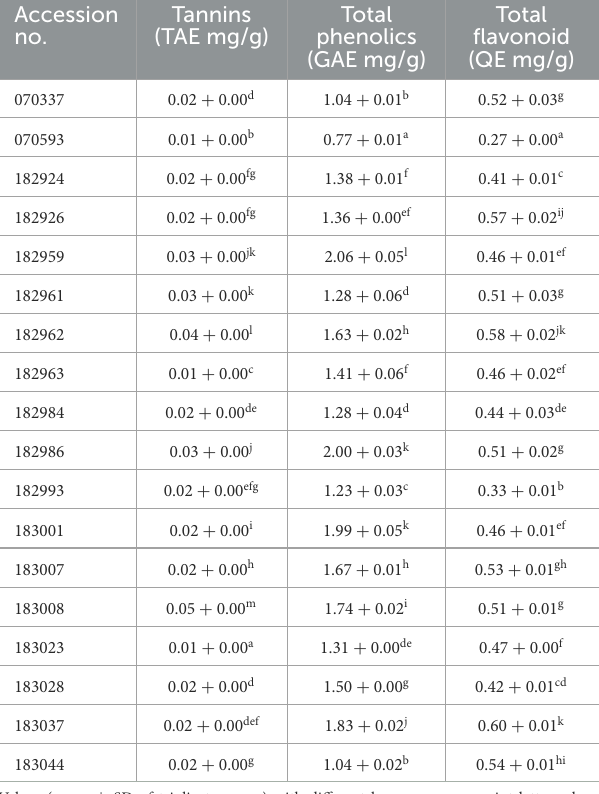
TABLE 2 Polyphenolics constituents of 18 elite yellow-fleshed cassava genotypes. Accession no.